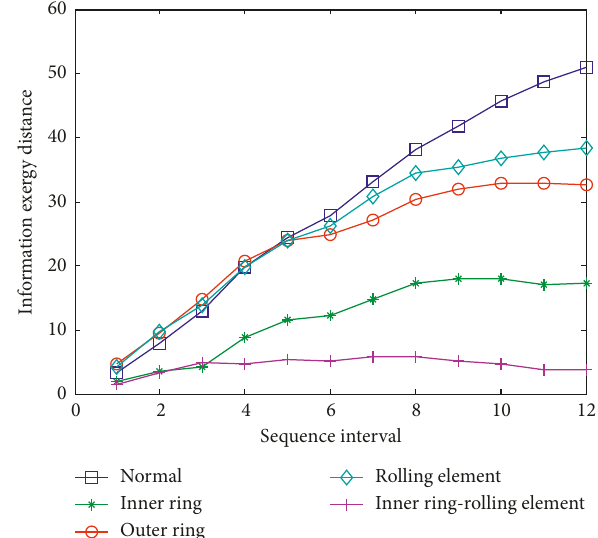
Figure 7: Information exergy distance of the outer ring fault.